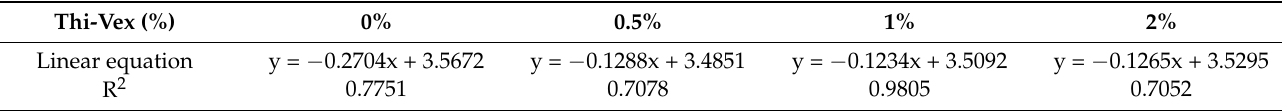
Table A1. Equations and R 2 values for individual trendlines in Figure 1a.